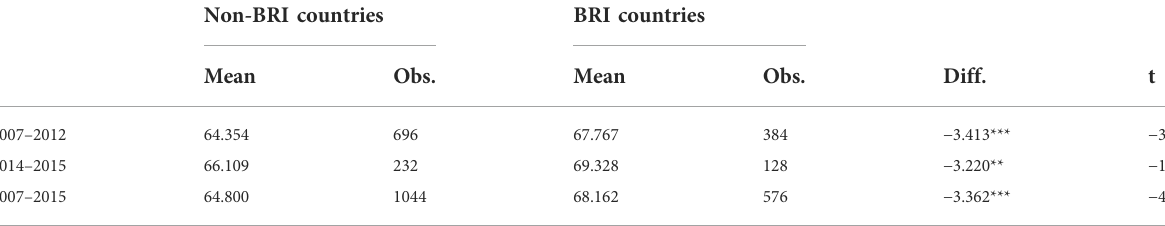
TABLE 15 The differences in environmental performance index between BRI countries and non-BRI countries.